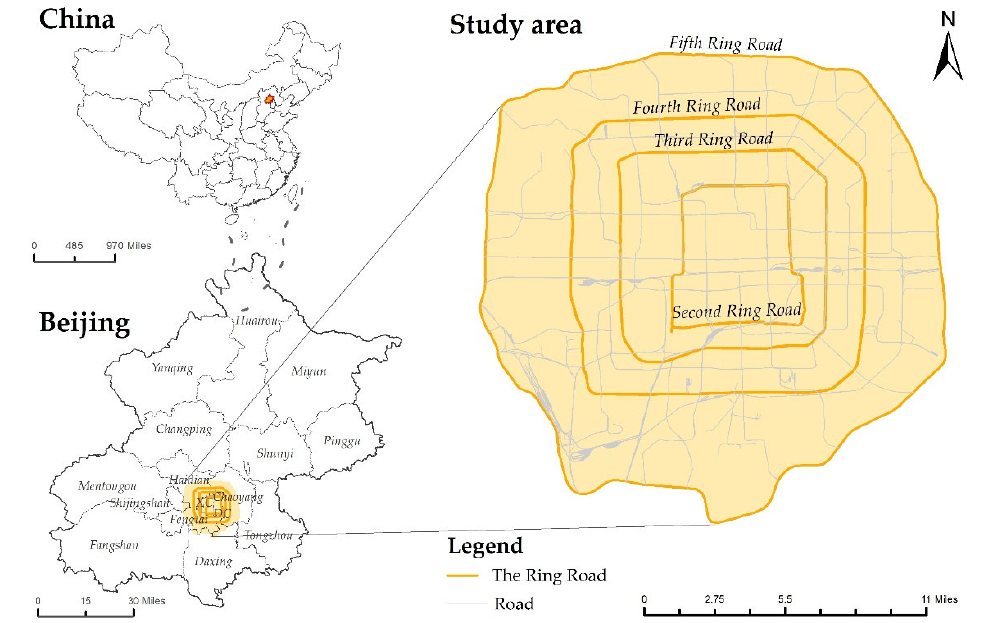
Figure 2. The study area in Beijing, China.